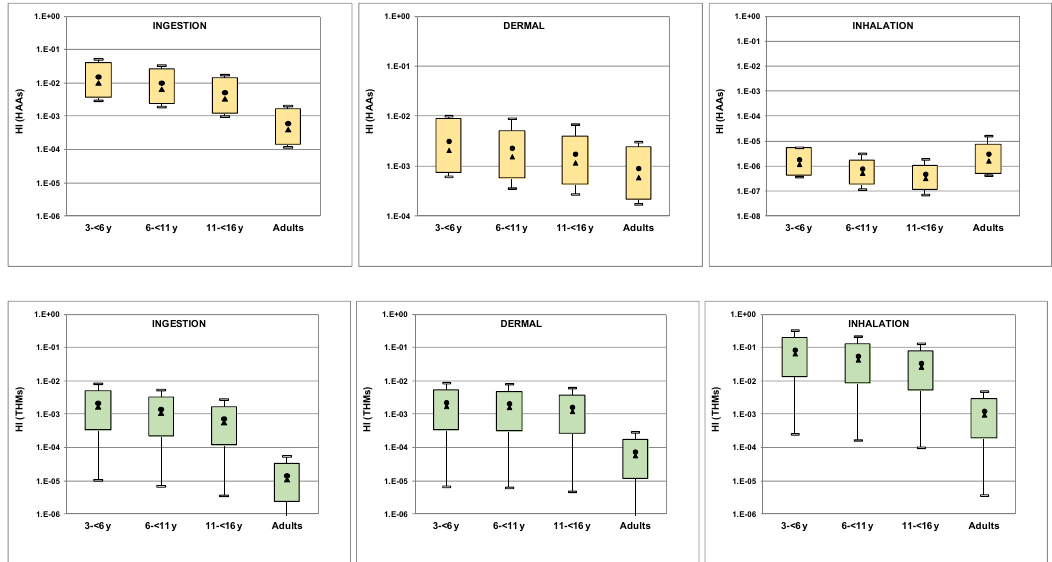
calculated since these DBPs were the most prominent compounds and their toxicity data